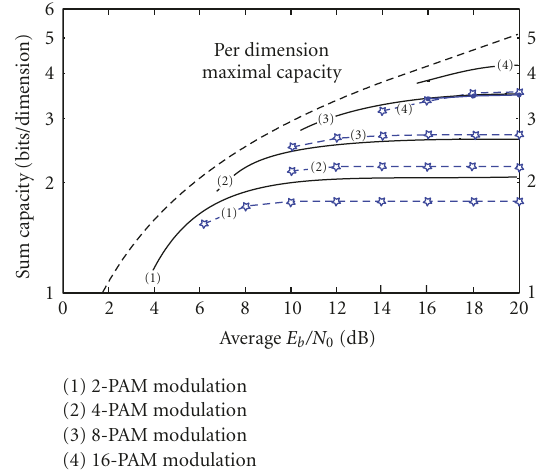
Figure 4: Achievable spectral e ffi ciencies using iterative demodula- tion of various PAM